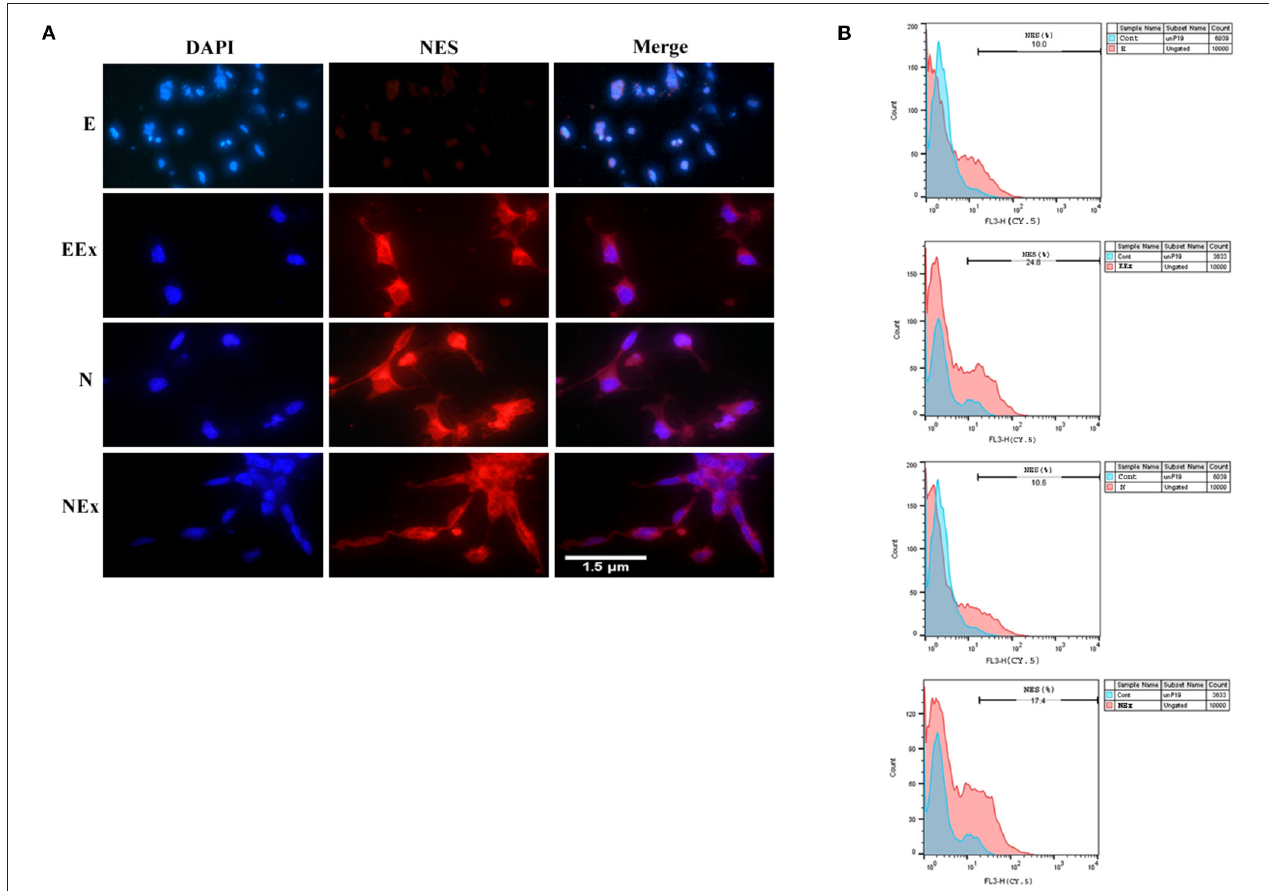
FIGURE 5 | Assessment of neuroepithelial marker, nestin in the second week of the differentiation protocol by: (A) immunofluorescence, and (B) flow cytometry. The results showed that the cells of all three experimental groups EEx, N, and NEx, were immunoreactive to nestin and the expression of this protein was higher in EEx and NEx groups. The cells in the E group showed no reactivity to nestin. DAPI was applied to counterstain the nuclei. NES, nestin; E (empty), EBs transfected with pCMV3-GFPSpark vector; EEx (empty/extract), EBs transfected with pCMV3-GFPSpark vector and treated by extract; N (Nurr), EBs transfected